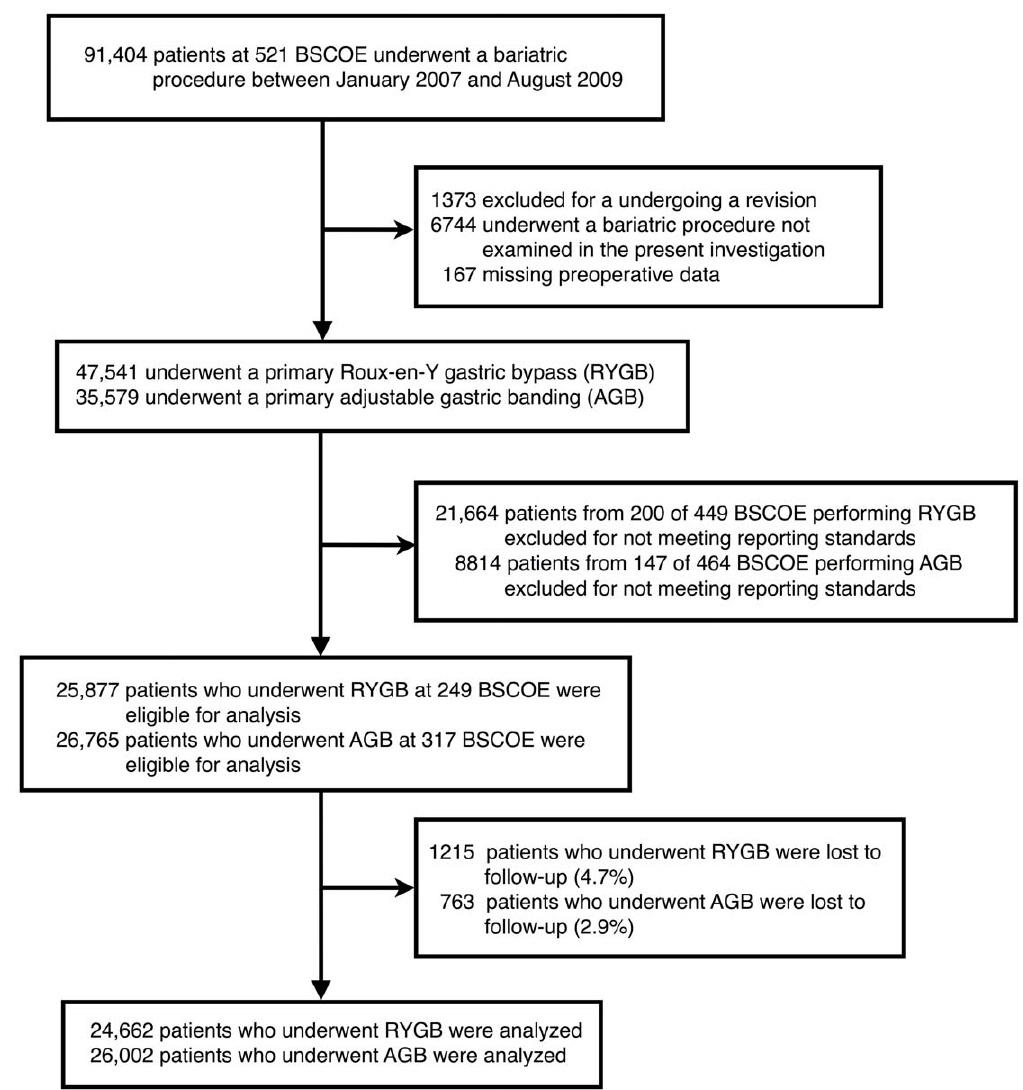
Figure 1. Flow diagram of patient selection.